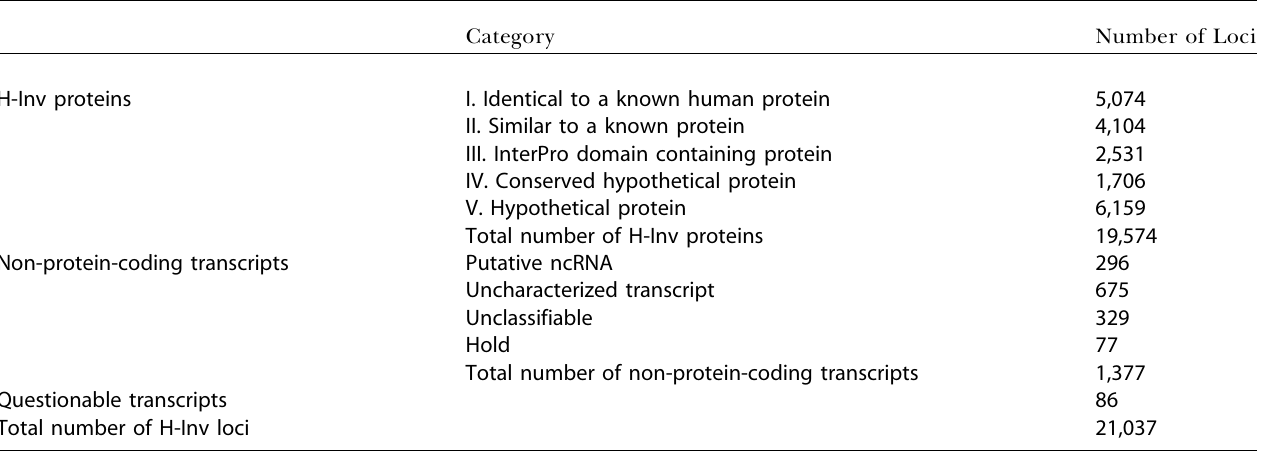
Table 3. Statistics Obtained from the Functional Annotation Results